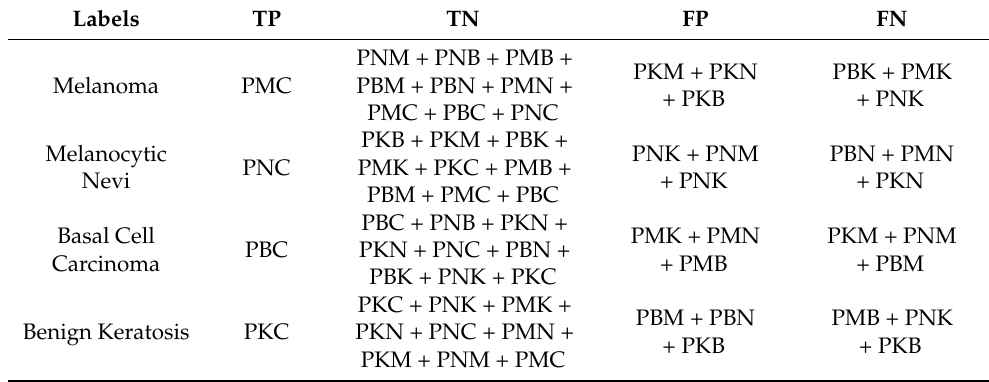
Table 4. Equations for confusion